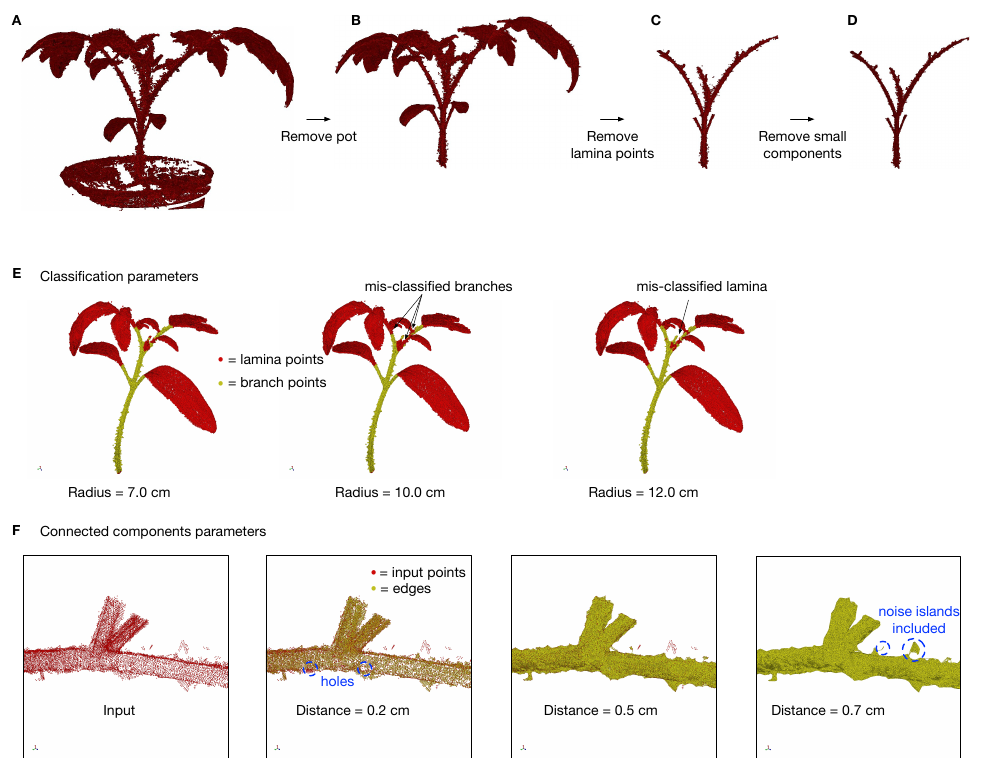
Figure 5. Pre-processing steps. ( A ) The raw input point cloud after scanning. ( B ) The point cloud after manually removing the pot. ( C ) The point cloud after removing lamina points with deep learning classification [30]. ( D ) The final set of branch points after removing small connected components. ( E ) The effect of the radius parameter on classification performance. The radius parameter is used to compute fast point feature histograms [42], which are used as feature vectors for classification. ( F ) The effect of the distance parameter on the connected components algorithm. The distance parameter is used to identify and remove isolated islands of points prior to applying our skeletonization